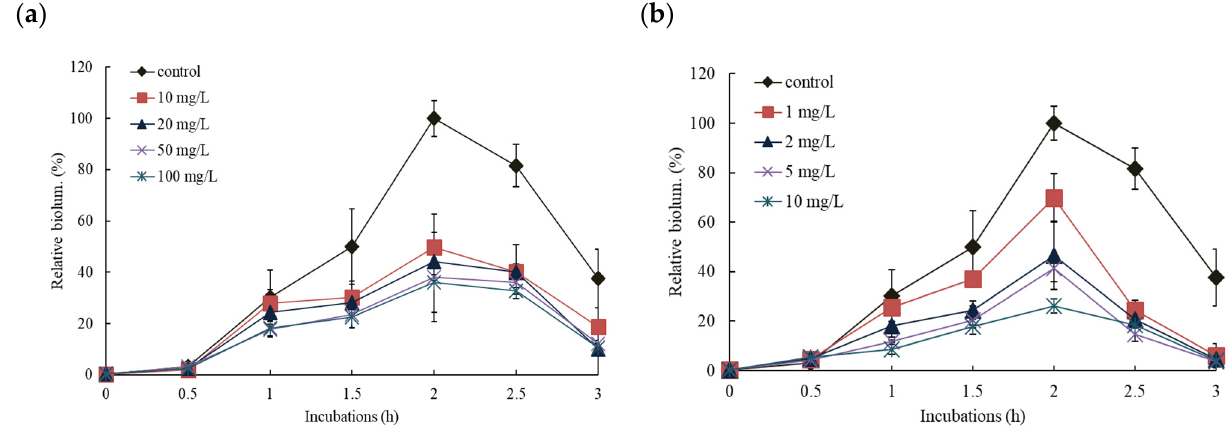
Figure 6. Effects of CuO and Al 2 O 3 NPs on the bioluminescence activity of RB1401 during 3 h incubation period, expressed by the relative activity of the maximum bioluminescence of the control: ( a ) 0–100 mg/L CuO exposure; ( b ) 0–10 mg/L Al 2 O 3 exposure.